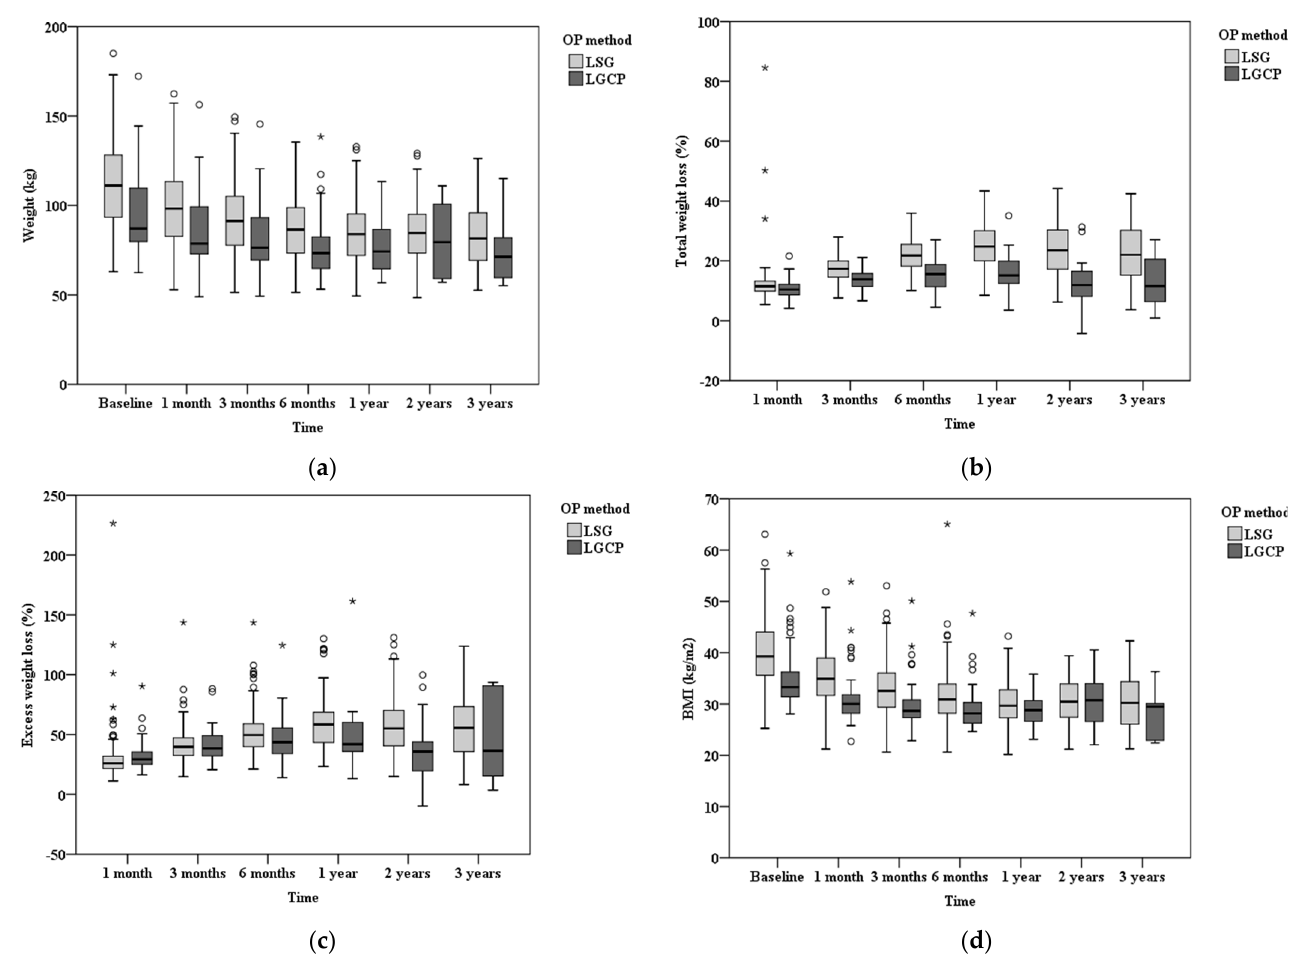
Figure 1. Changes in (a) weight, (b) % total weight loss, (c) % excess weight loss, and (d) body mass index (BMI) between laparoscopic greater curvature plication (LGCP) and laparoscopic sleeve gastrectomy (LSG) groups over long-term follow-up. When a value differs by more than 1.5 × IQR from the range of the first and third quartiles, the value is an outlier. Both circles and asterisks are outliers. The circles represent values outside the range of 1.5×IQR to 3×IQR, called mild outliers. Asterisks indicate values that are outside the range of more than 3×IQR and are called extreme outliers.